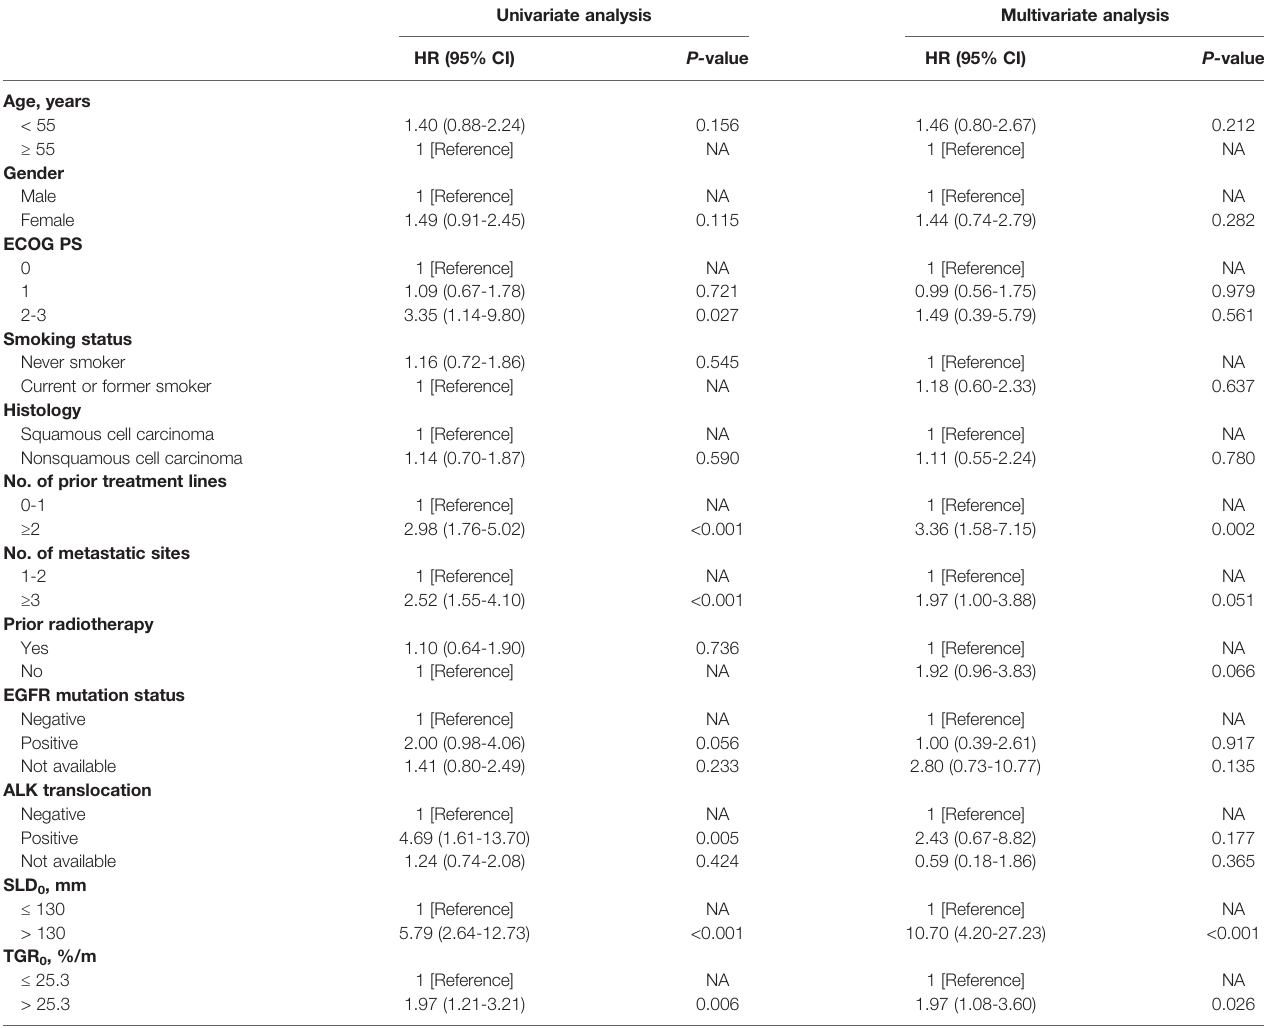
TABLE 3 | Univariate and multivariate analyses of progression-free